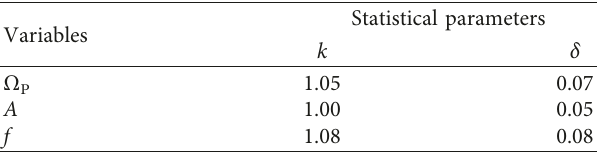
Table 1: Statistical parameters of resistance for strength calculation of axially loaded members.